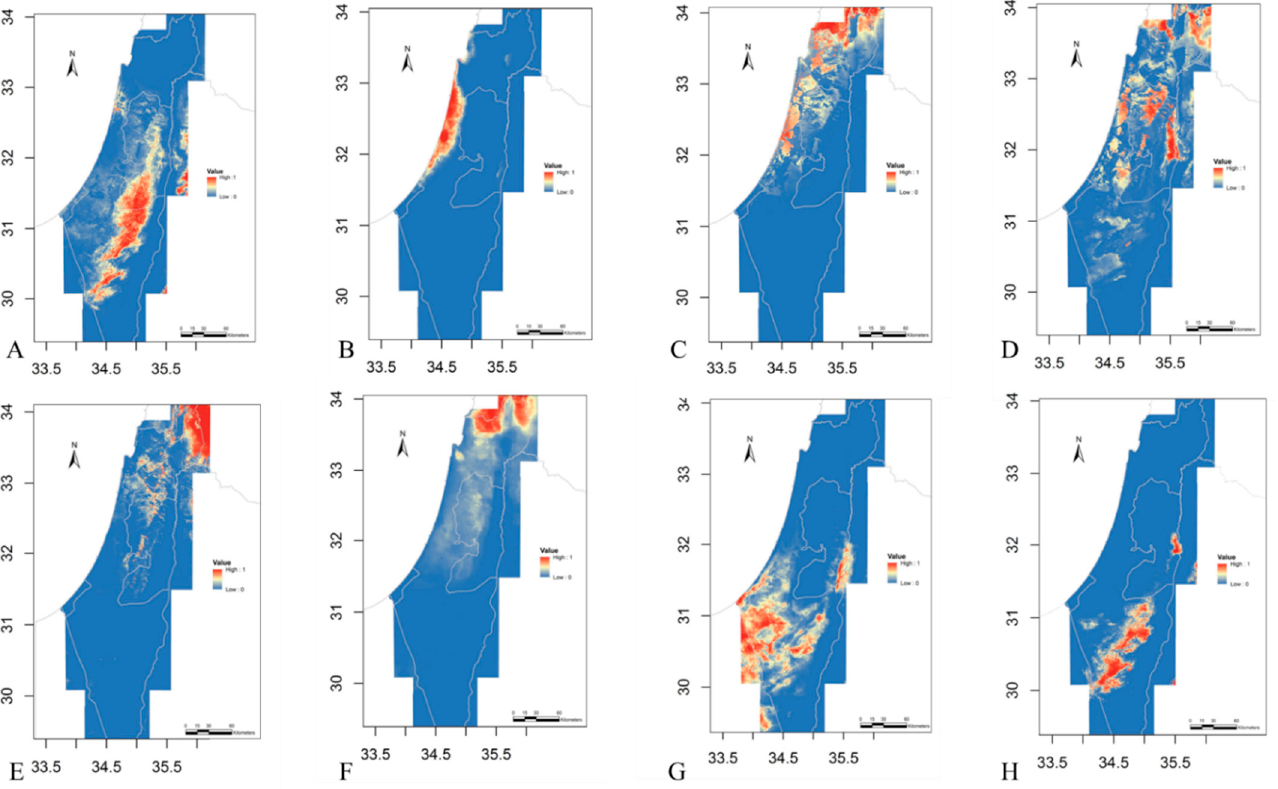
Figure 2. The potential distribution of the eight Israeli Oncocyclus irises, as predicted by the SDMs. The probability to find a species in a certain environment range from 0 (dark blue), through 0.5 (yellow) to 1 (red). ( A ) Iris atrofusca ; ( B ) I. atropurpurea ; ( C ) I. bismarckiana ; ( D ) I. haynei ; ( E ) I. hermona ;